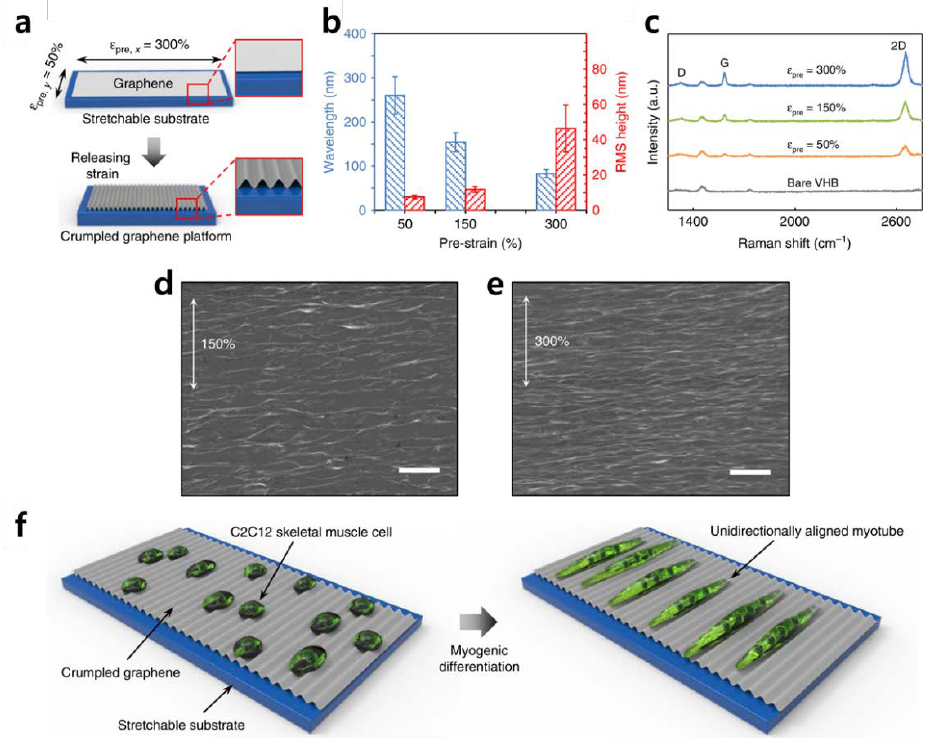
Figure 4. ( a ) Schematic illustration of fabricating the crumpled graphene. ( b ) Wavelength and root mean square height of crumpled graphene substrates. ( c ) Raman spectroscopy intensity of the crumpled graphene on VHB substrates by condition. ( d – e ) Scanning electron microscopy images of crumpled graphene fabricated from 150% and 300% prestrains. Scale bars: 1 μm. ( f ) Schematic illustrations of the myogenic differentiation of C2C12 cells on crumpled graphene. The reprint of this figure from [84] is permitted by Springer Nature.